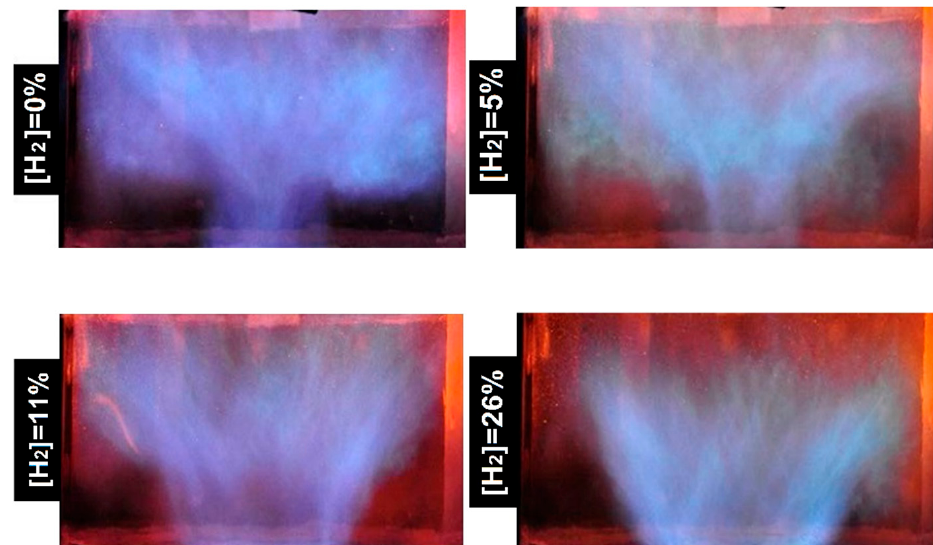
Figure 10. A change in the shape of the flame with the addition of hydrogen by volume [23]. Similar results were obtained in the paper by Indlekofer [27], where it was shown that the flame with a higher hydrogen percentage was characterized by a more compact shape, which indicates a better reactivity of the fuel mixture (Figure 11).